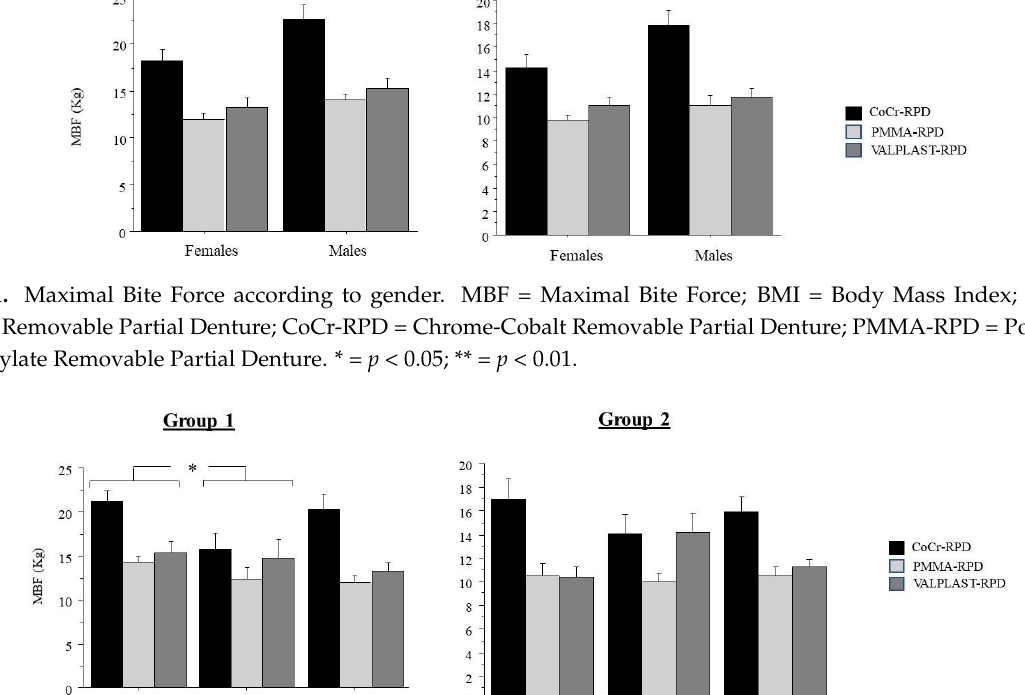
Figure 1. Maximal Bite Force according to gender. MBF = Maximal Bite Force; BMI = Body Mass Index; V-RPD = Valplast Removable Partial Denture; CoCr-RPD = Chrome-Cobalt Removable Partial Denture; PMMA-RPD = Polymethyl Methacrylate Removable Partial Denture. * = p < 0.05; ** = p < 0.01.